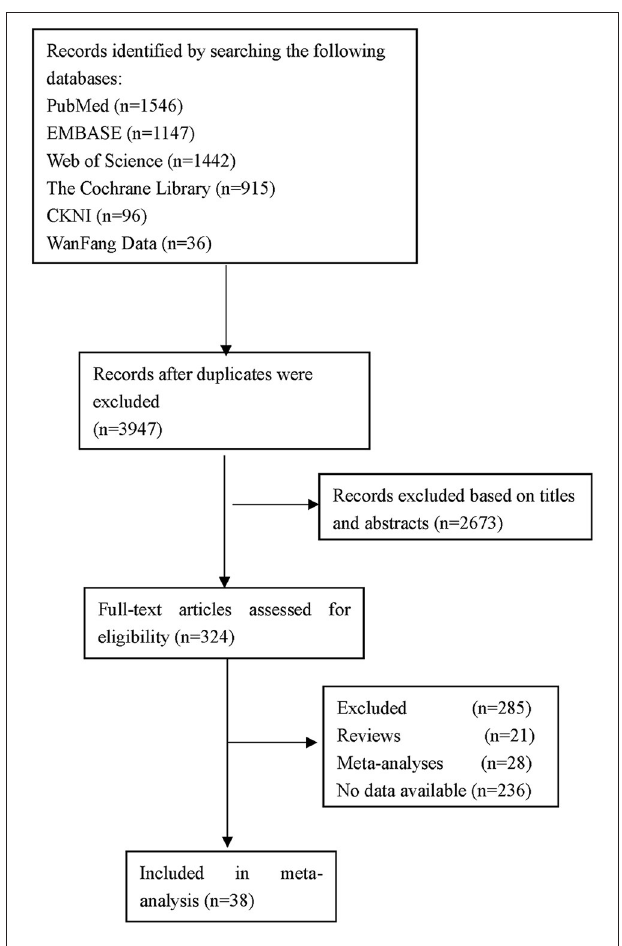
FIGURE 1 | Flow diagram of the selection of studies.